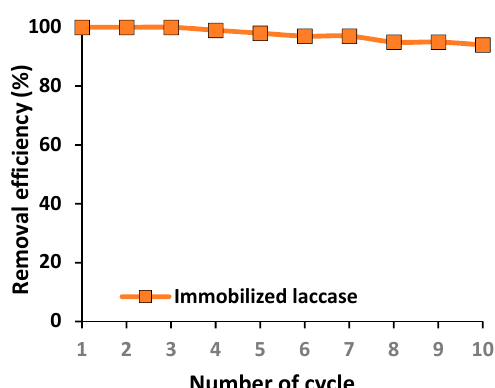
Figure 9. Reusability of the immobilized laccase over repeated catalytic cycles. The error value in each of the experiments (based on the mean and standard deviation from three experiments) does not exceed 3.5%.